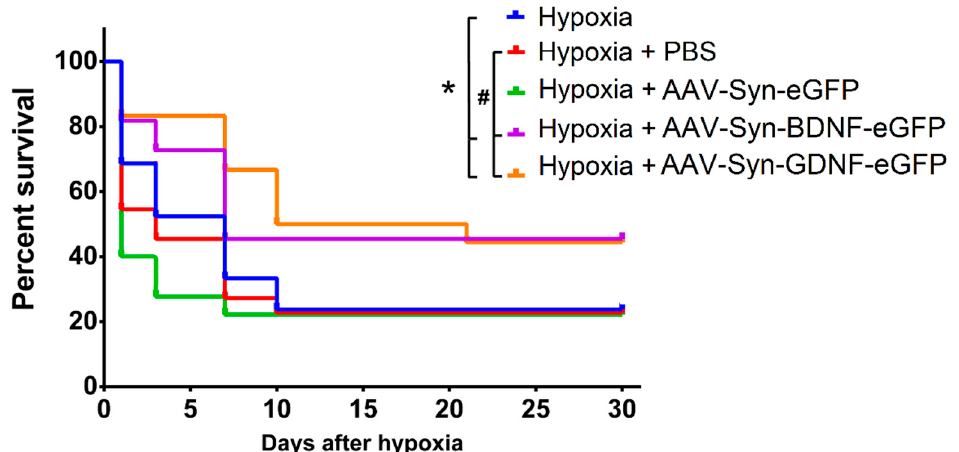
Figure 4. Survival rate of male C57BL/6 mice after simulating acute hypobaric hypoxia amid preventive administration of AAV-Syn-BDNF-eGFP and AAV-Syn-GDNF-eGFP viral vectors (“Hypoxia” n = 21; “Hypoxia + PBS” n = 22; “Hypoxia + AAV-Syn-eGFP” n = 18; “Hypoxia + AAV-Syn-BDNF” n = 22; “Hypoxia + AAV-Syn-GDNF” n = 18). The statistical difference from “Hypoxia” (*) or “Hypoxia + PBS” (#) was calculated by a long-rank Mantel-Cox test, *, # p < 0.05. It was also revealed that transduction by the AAV-Syn-GDNF-eGFP vector increases